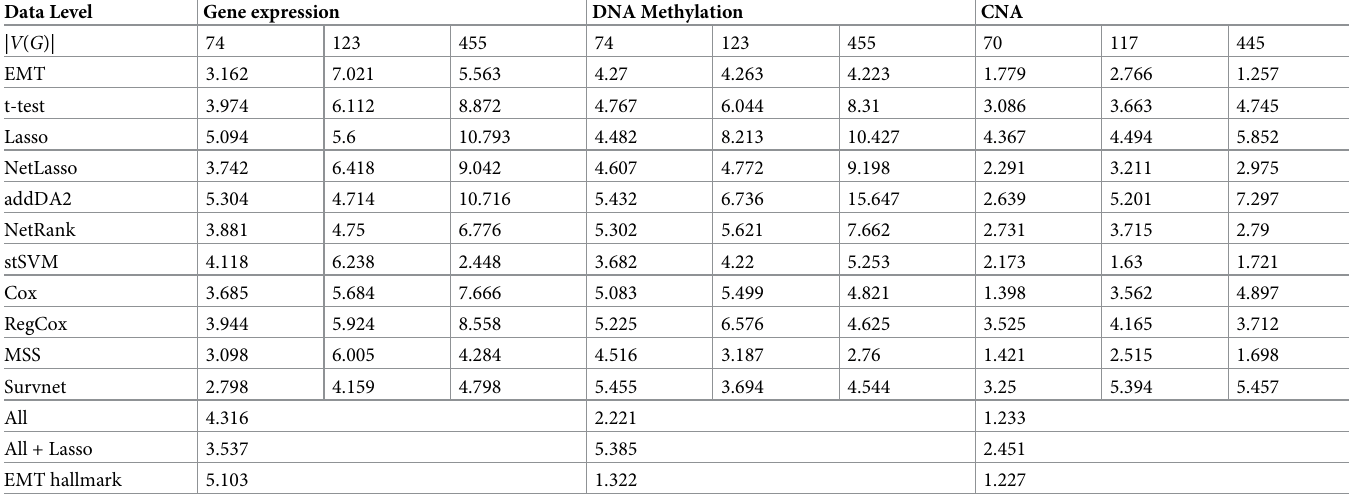
Table 5. The average odds ratios of EMT signatures on three data levels. The table gives the average odds ratios of EMT signatures on three data levels with each EMT network. The results from comparative groups 2, 3, 4, and 5 are given in the third row and the last three rows. Data Level Gene